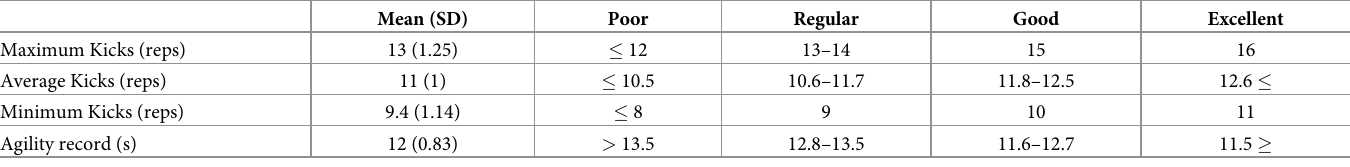
Table 3. Classificatory results for the number of kicks (n = 48) and agility records (n = 50) obtained from the taekwondo-specific aerobic-anaerobic-agility (TAAA) test � . Mean (SD) Poor Regular Good Excellent Maximum Kicks (reps) 13 (1.25) � 12 Average Kicks